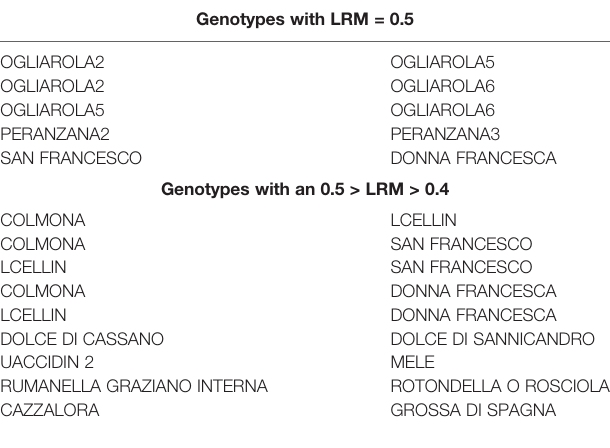
TABLE 3 | List of pairwise relatedness based on LRM estimator (Lynch and Ritland, 1999). Genotypes with LRM =